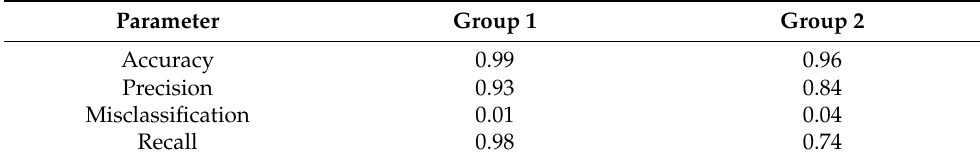
Table 1. Evaluation parameters of the MLP model of both groups.